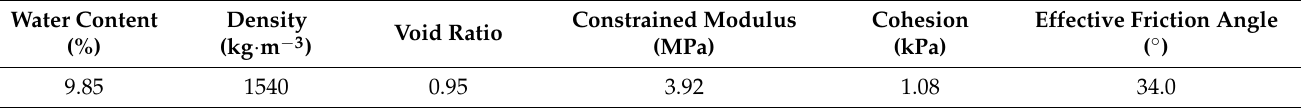
Table 2. Physical and mechanical properties of sandy silt.